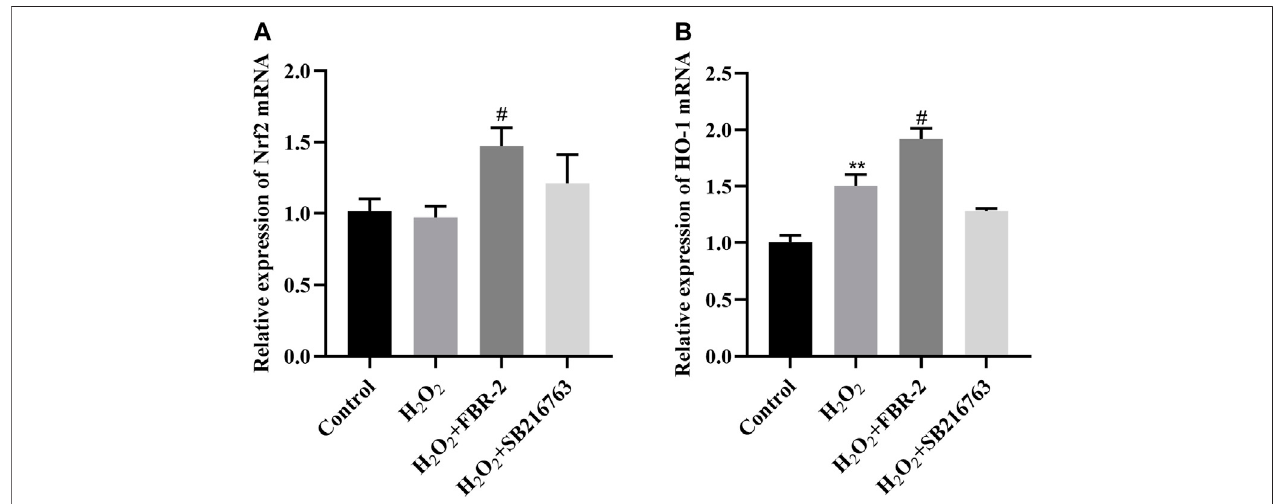
FIGURE 5 | FBR-2 increased the expression of Nrf2 and HO-1 mRNA in A549 cells. (A) Nrf2 mRNA levels ( n = 6). (B) HO-1 mRNA levels ( n = 6). ** p < 0.01, compared with the control group; # p < 0.05, compared with the H 2 O 2 group.